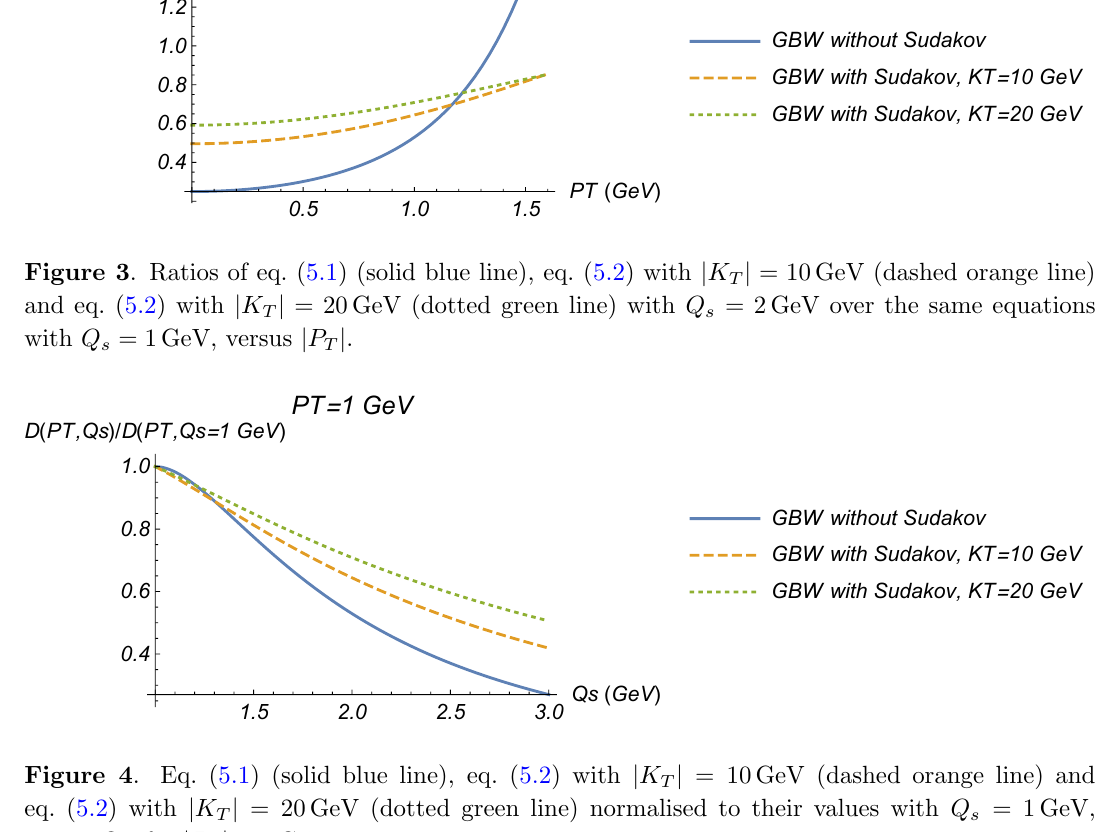
K T = 20 GeV (dotted green line) normalised to their values with Q s = 1 GeV, j j P T = 1 j j